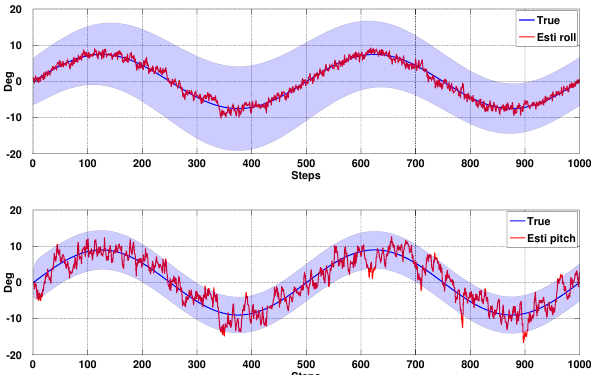
Figure 10. Simulation results for PBVS tracking: angle estimation. ˆ φ and ˆ θ with 3 σ confidence